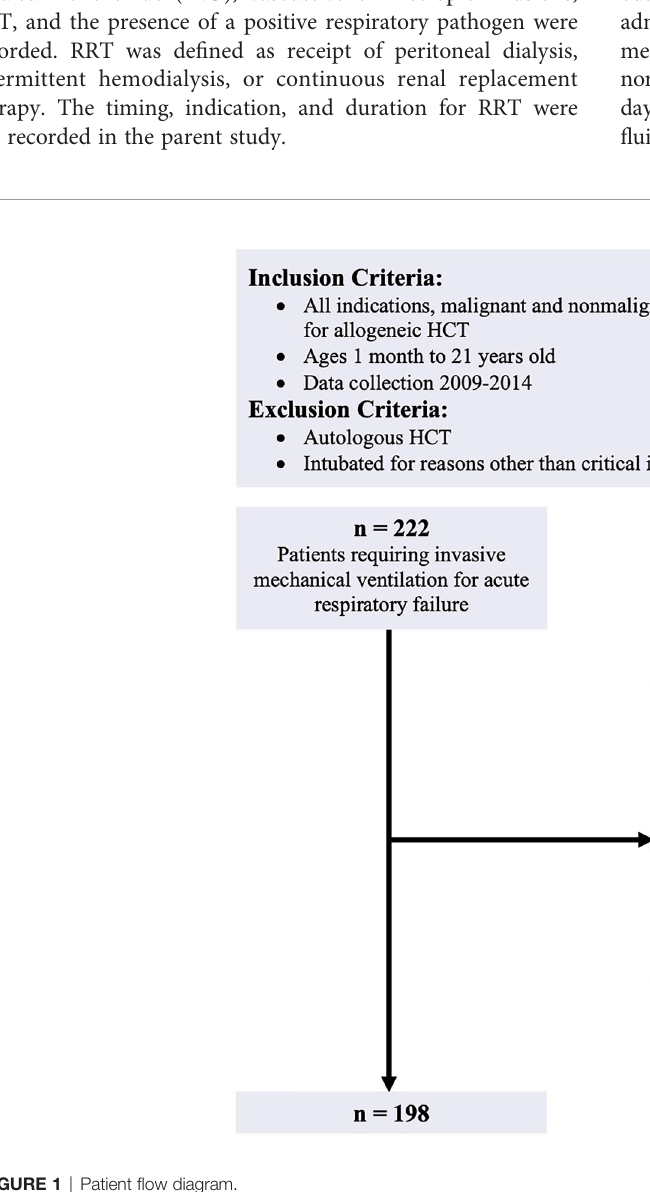
FIGURE 1 | Patient fl ow